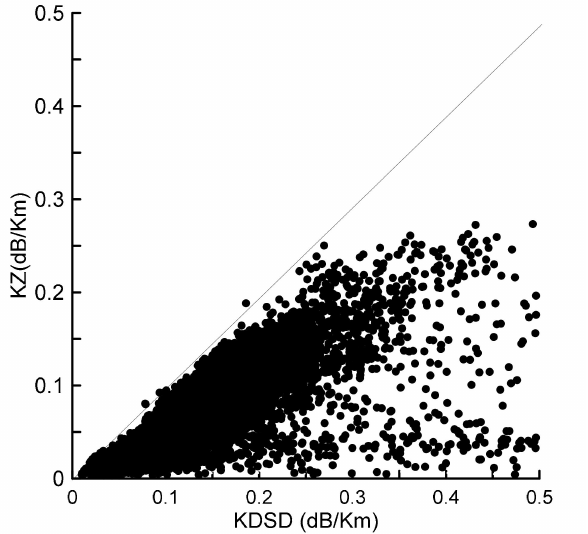
Figure 3. Comparison between attenuation coe ffi cients by the drop size distribution (DSD) algorithm and the K–Z relationship. KDSD is from the DSD algorithm and KZ is from the K–Z